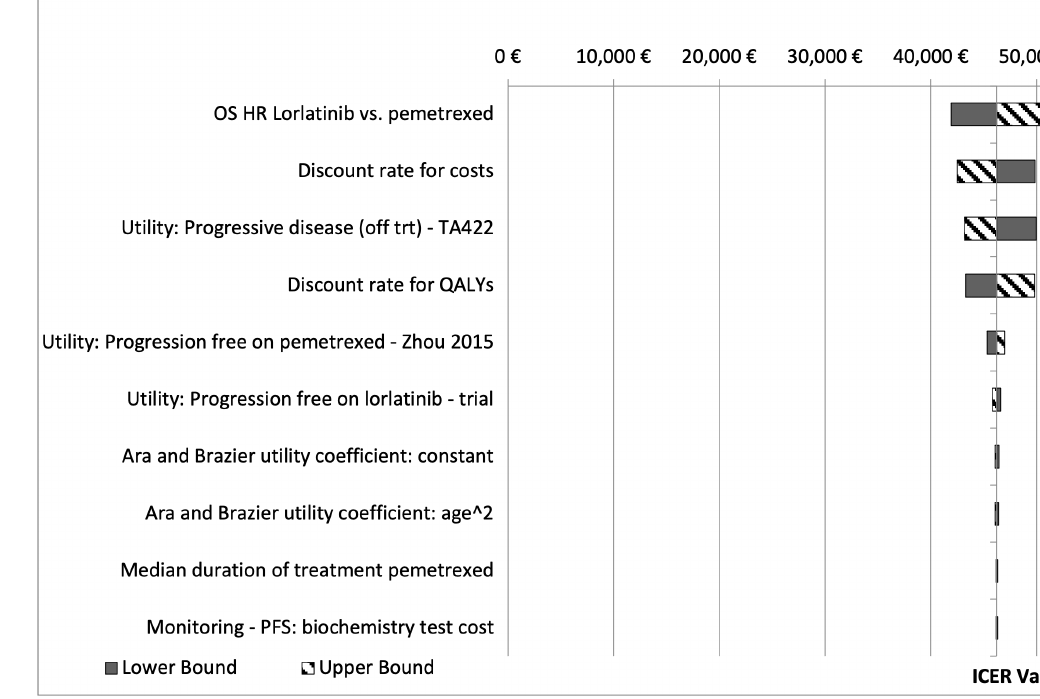
Figure 2. Tornado Diagram of One-Way Sensitivity Analysis: Loratinib vs